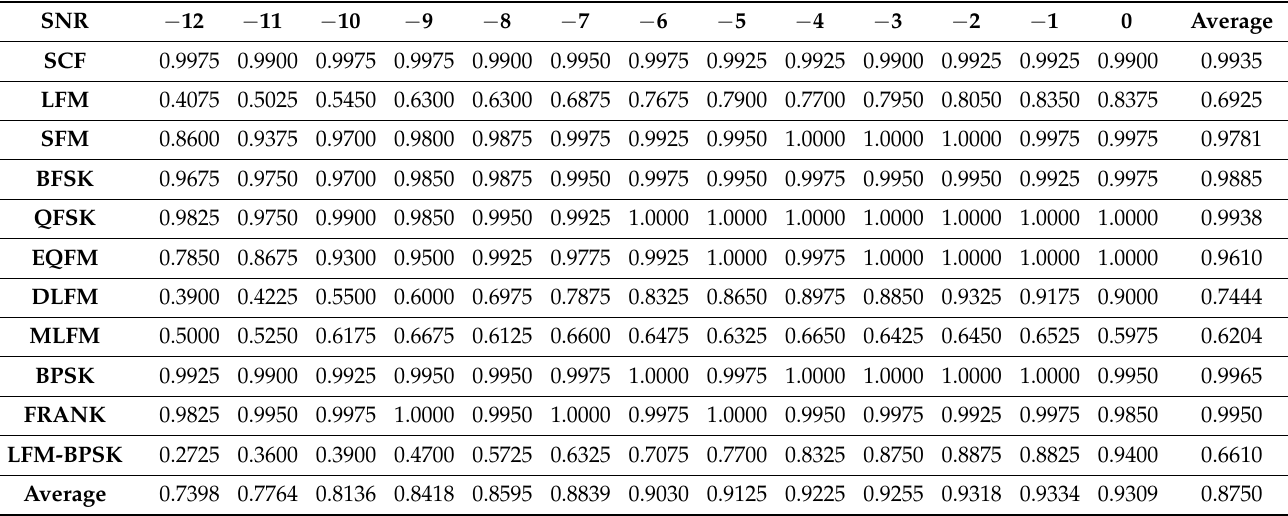
Table A4. Semi-supervised classification results of our proposed method with the datasets in Situation Dataset